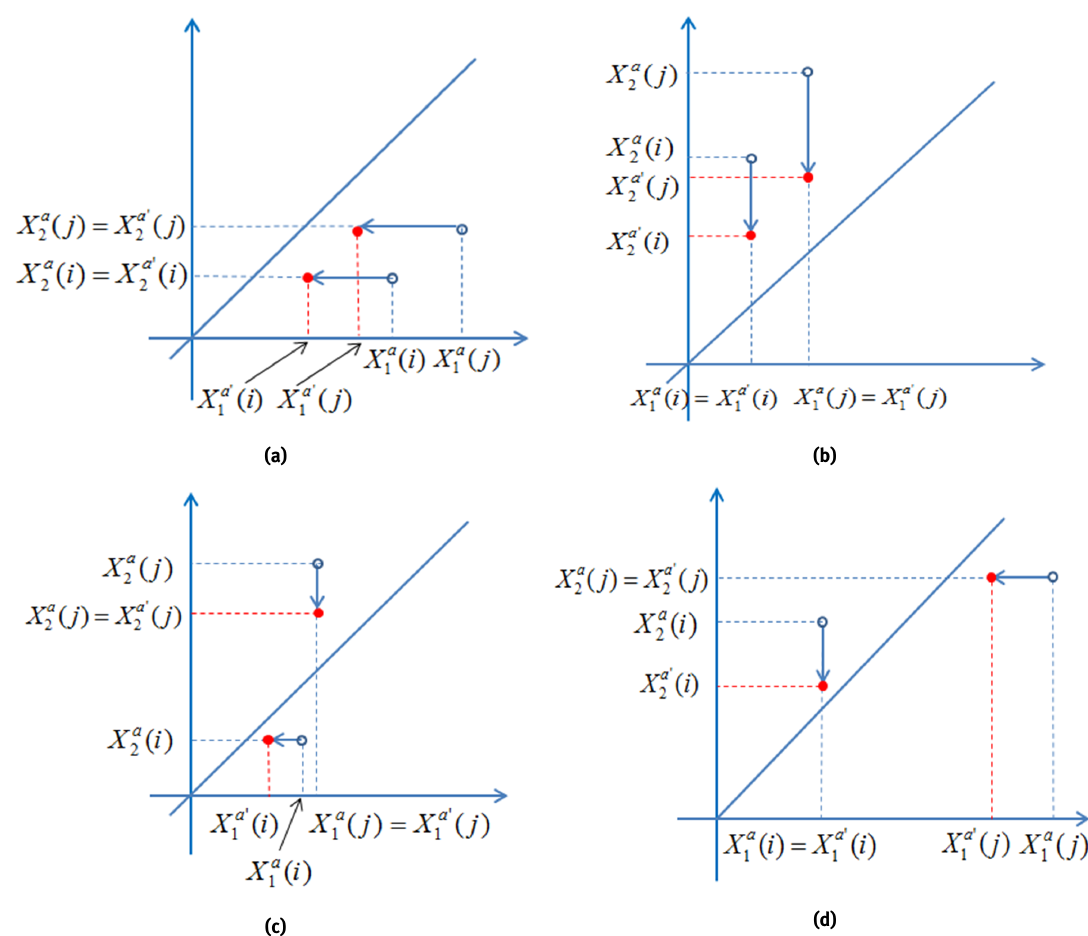
Figure 6: The four possible positions of a concordant pair ( i , j ) (marked by ◦ ). The transformed sample (marked by • ). Concordant pairs remain